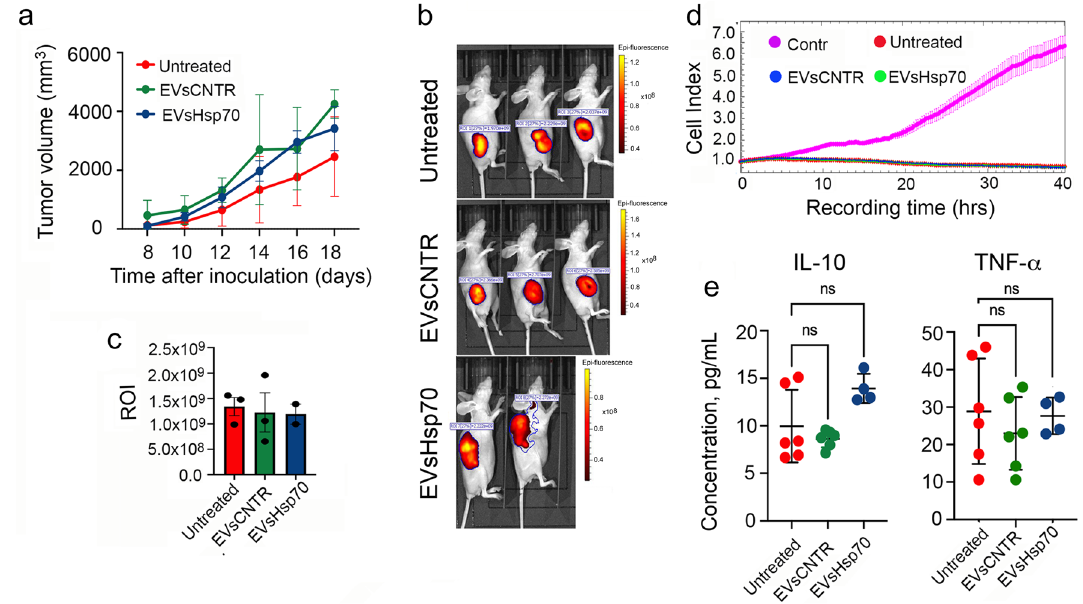
Figure 6. Lack of CD8 + T-cell response in Balb/c nude mice abandons antitumor effect of EVsHsp70. ( a ) Tumor volume was measured each 2nd day, starting from day 7 in Balb/c nude mice (n = 3 in each group). ( b ) tumors were monitored using the IVIS Spectrum imaging system (filters: excitation: 675 nm, emission: 720 nm). Representative biofluorescence images. ( c ) Fluorescence count of tumor lesions. ( d ) Lymphocytes from three groups for CT-26-bearing Balb/c nude mice of three experimental groups were used as effector cells in the CTL assay performed with the aid of xCELLigance (total fraction). ( e ) The concentration of two cytokines (IL-10 and TNF-α) were measured in sera of CT-26-bearing Balb/c nude mice on day 19 after tumor cell